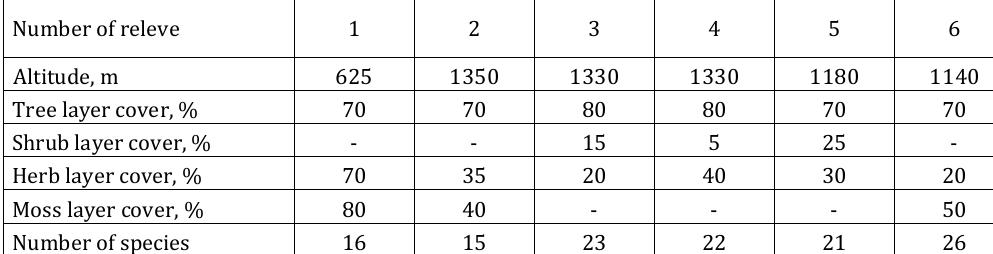
Table 2. Syntaxonomical characteristics of the association Luzulo luzuloidis-Fagetum (Du Rietz 1923) Markgraf 1932 Number of releve 1 Altitude, m 625 Tree layer cover, % 70 Shrub layer cover, % - - Herb layer cover, % Moss layer cover, % Number of species Diagnostic species of the association Luzulo luzuloidis-Fagetum : Vaccinium myrtillus Luzula sylvatica Dryopteris expansa Huperzia selago Diagnostic species of the class Quercetea robori-petraea : Calamagrostis arundinacea Cystopteris fragilis Oxalis acetosella Sorbus aucuparia - Other species: Picea abies Fagus sylvatica Acer pseudoplatanus Athyrium filix-femina Maianthemum bifolium Phegopteris connectilis